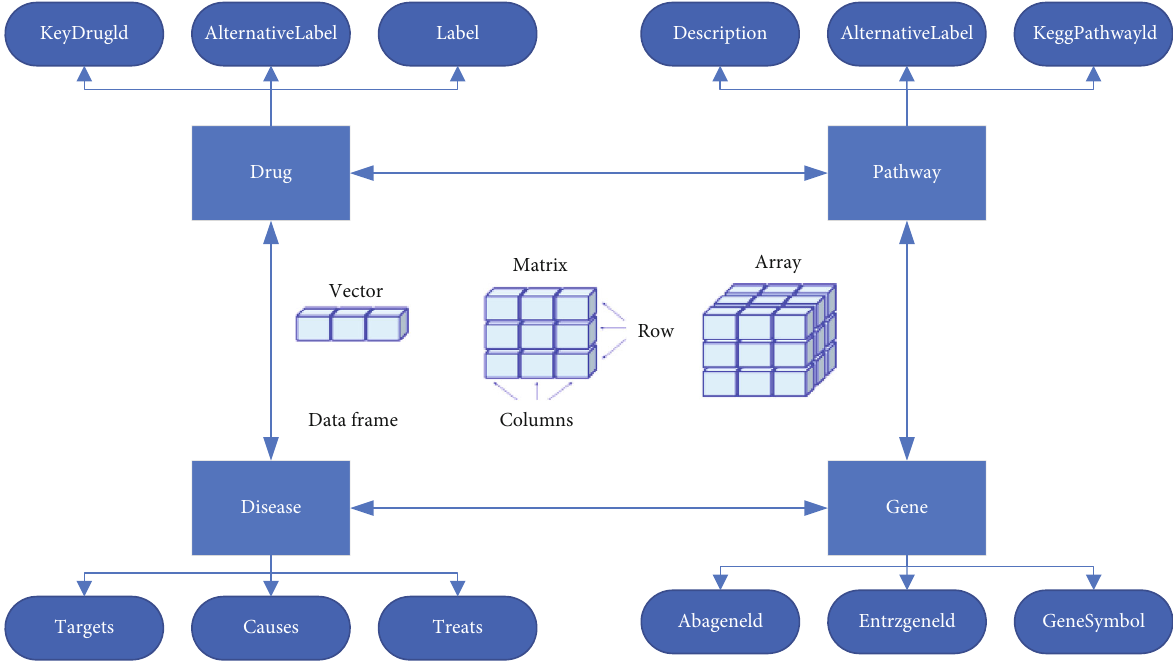
Figure 2: Schematic diagram of IList